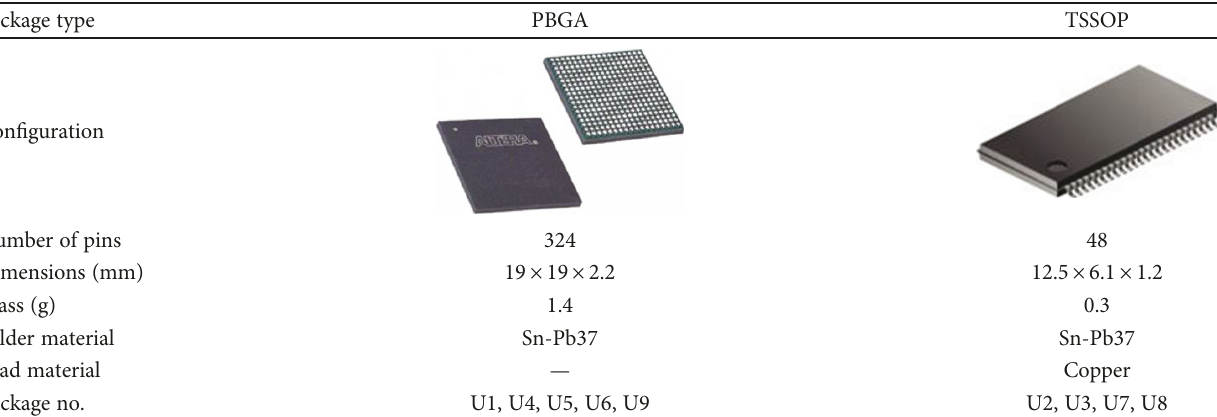
Figure 10: FEM of PCB with PBGA packages and TSSOPs. Table 7: Speci fi cation of electronic